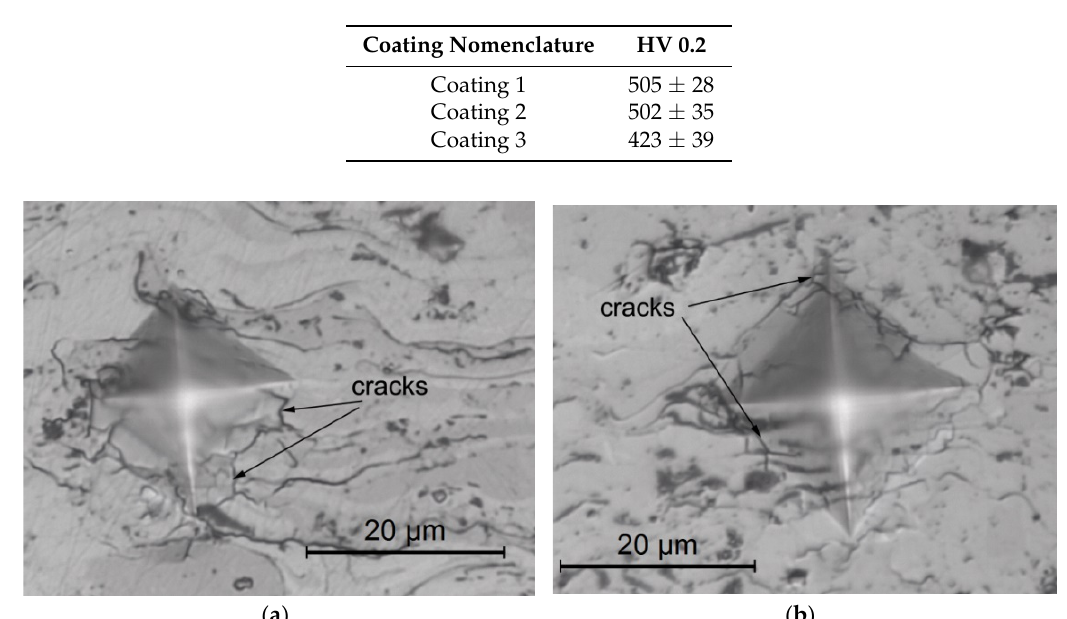
Figure 6. Cracks formed at the indentations of ( a ) coating 2 and ( b ) coating 3.